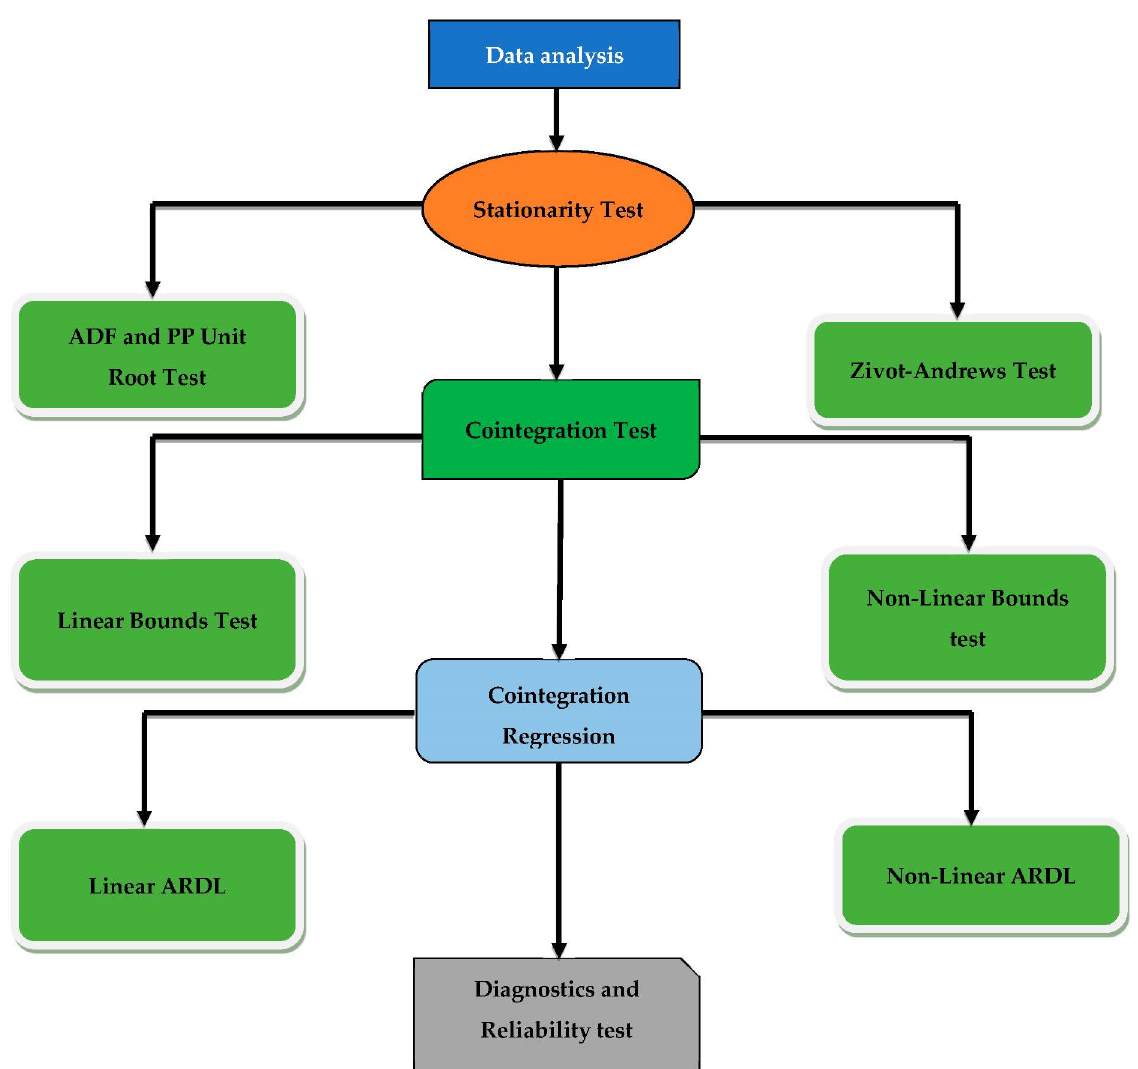
Figure 2. Methodological flow chart (source: authors’ creation).